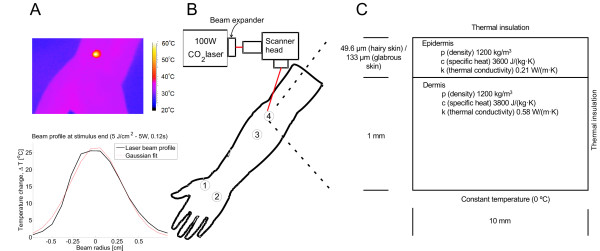
The figure illustrates the experimental setup and the parameters used for the finite element model. In A the laser beams spatial profile is seen in the infrared camera. The slight skewed look of the profile is most likely due to fact that the cameras line of sight was not perpendicular to the skin surface. But it could also be due to the poor spatial resolution of the infrared camera and an inaccuracy of the laser optics. However, a Gaussian fit of the laser beam showed that the laser beam fits a Gaussian profile with an r2 of 0.984. In B the experimental setup is displayed. It consists of a 100 W CO2 laser with a beam expander and scanner head. The latter directs the laser beam to the desired skin sites. In C the principle behind the finite element model is displayed including thermal constants, geometric sizes and simulation properties. The lower boundary is kept at a constant temperature (0°C). Note that the initial temperature in the model is 0°C. This mimics how the thermal energy deeper into the tissue which is the primary cooling effect during laser stimulation.